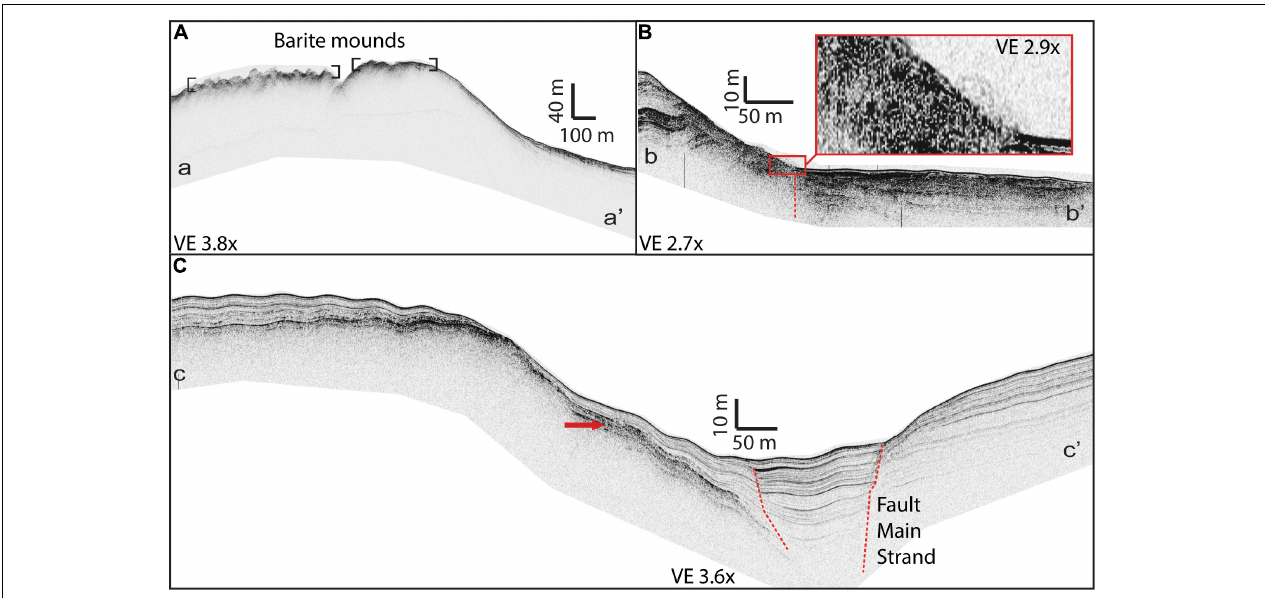
FIGURE 4 | Chirp profiles from study areas on the San Clemente and San Diego Trough Faults. Profile locations are shown in Figures 1 , 2 . (A) Chirp profile parallel to San Clement Fault showing a fuzzy, bumpy appearance indicating the presence of barite mounds. (B) Chirp profile that crosses San Clemente Fault near the Navy Fan. Inset in B is an enlargement of the fuzzy appearance of barite mounds. (C) Chirp profile that crosses the San Diego trough Fault. The arrow in C indicates the depth where a barite deposit was found during ROV dive DR769. Faults are shown as dashed red